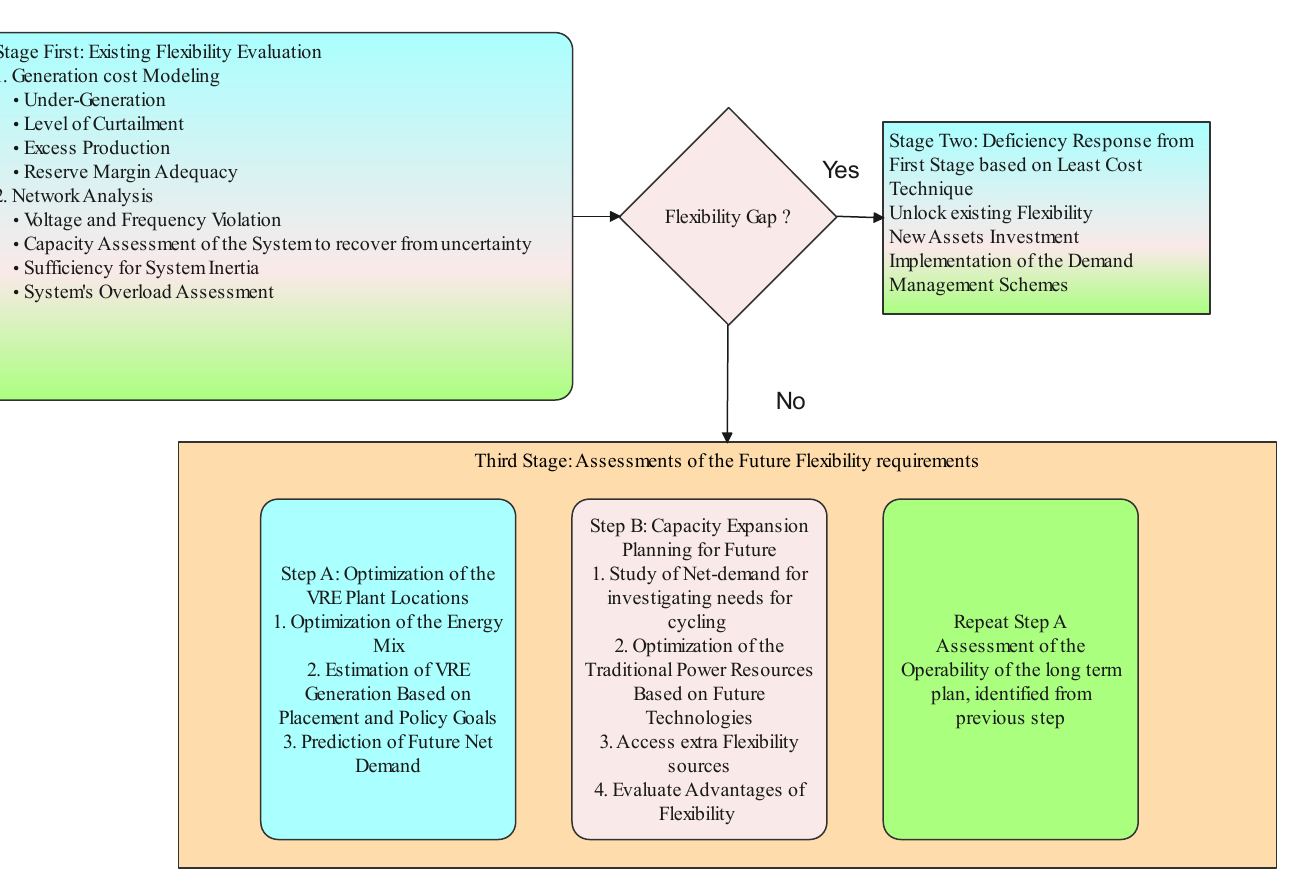
Figure 10. Power system flexibility